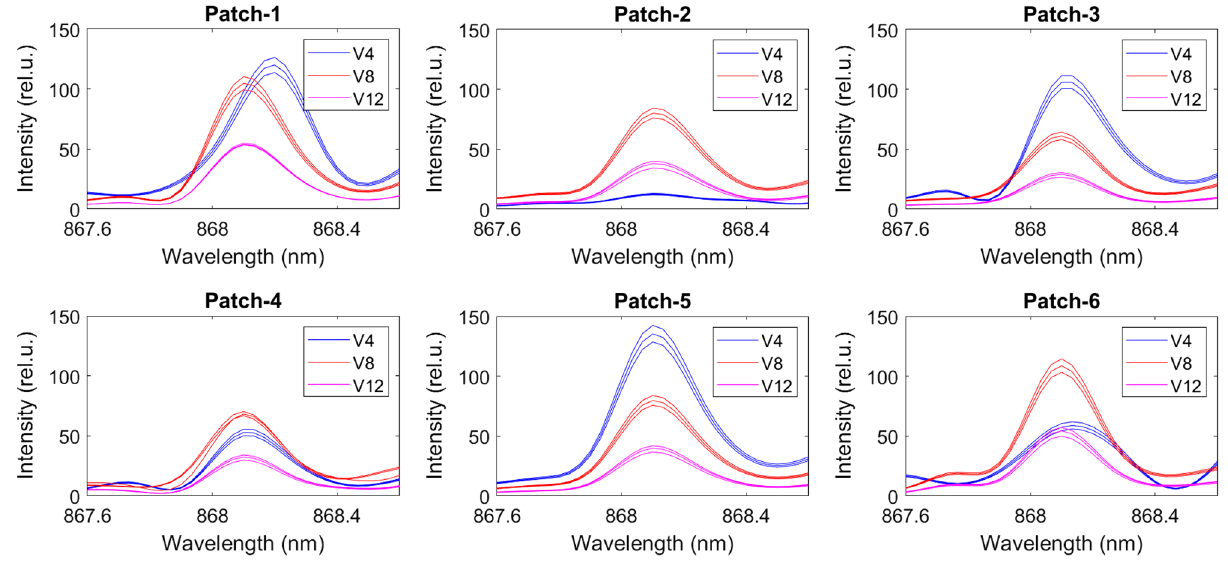
Figure 7. Nitrogen spectrum of the soil samples at 868.1 nm for six patches at the V4, V8 and V12 stages.